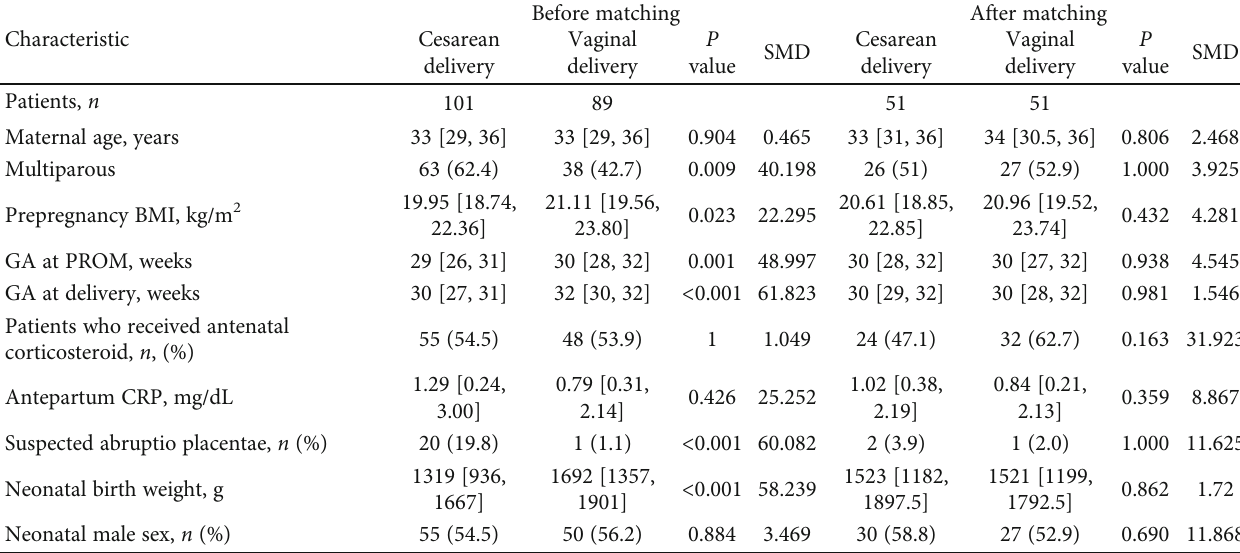
Table 1: Baseline patient characteristics before and after propensity score